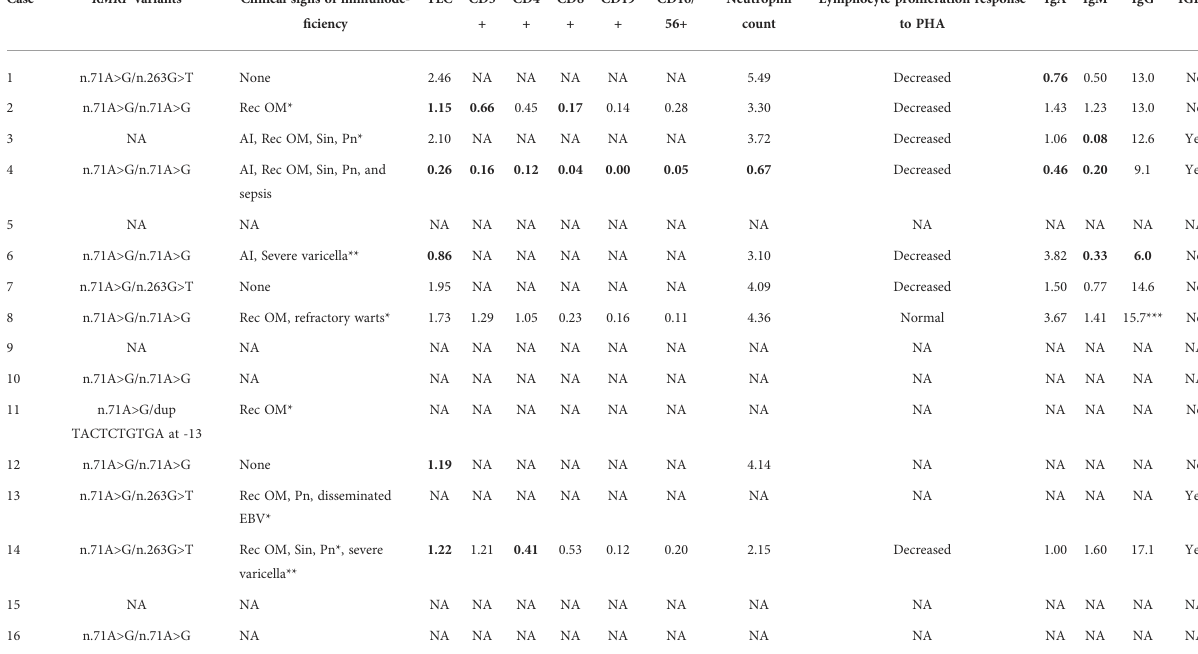
TABLE 3 Characteristics of immunode fi ciency in the 16 study